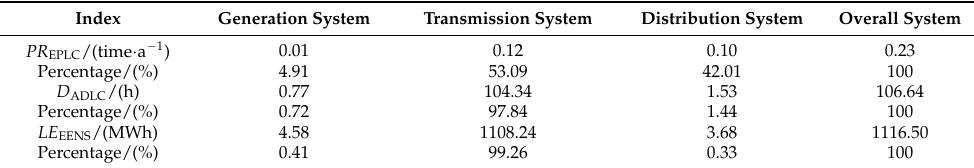
Table 8. Subsystem load shedding index.